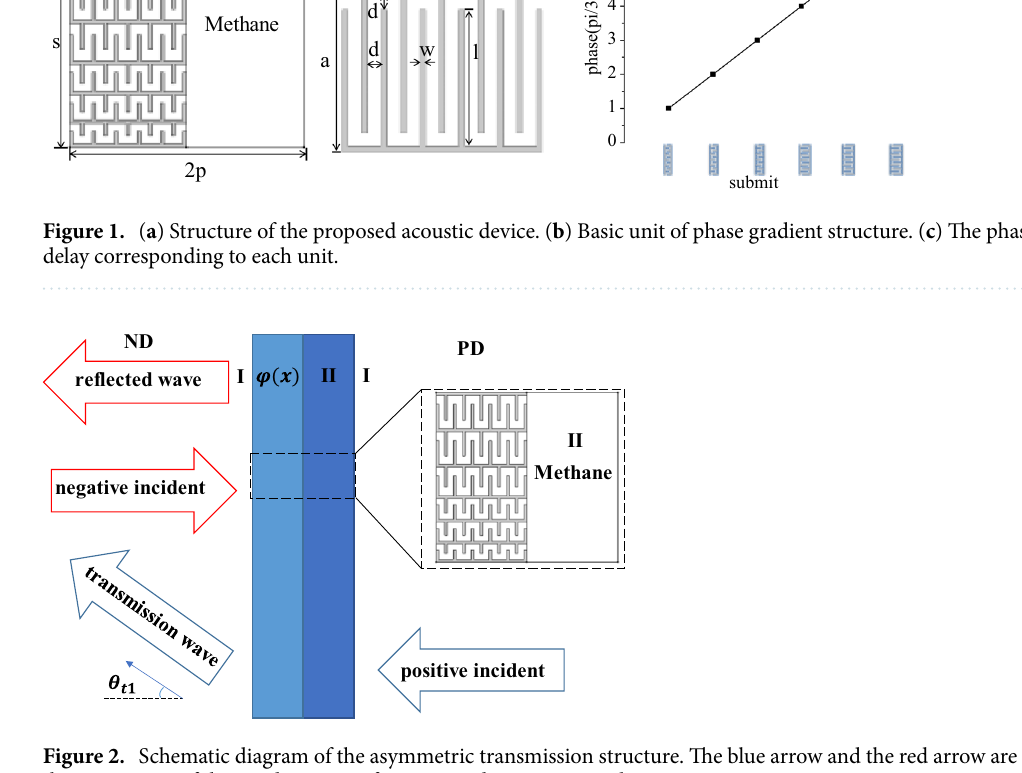
Figure 2. Schematic diagram of the asymmetric transmission structure. The blue arrow and the red arrow are the trajectories of the incident waves from PD and ND